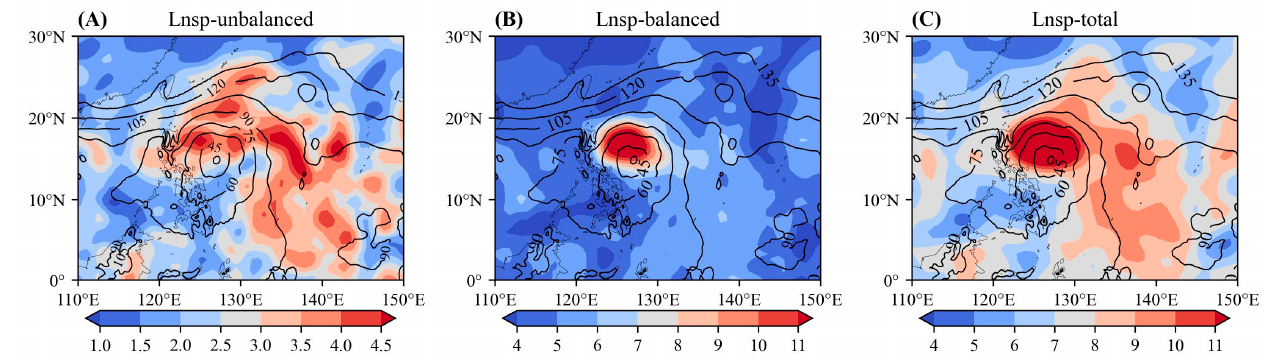
Figure 2. Standard deviations of the logarithm of surface pressure in the fully flow-dependent experiment corresponding to 1200 UTC 19 October 2020. The total standard deviations ( C ) are decomposed into vorticity-balanced parts ( B ) and residual unbalanced parts ( A ). Unit: 10 − 4 hPa. The corresponding 1000 hPa geopotential height analysis is overlaid, contour: 15 dagpm.